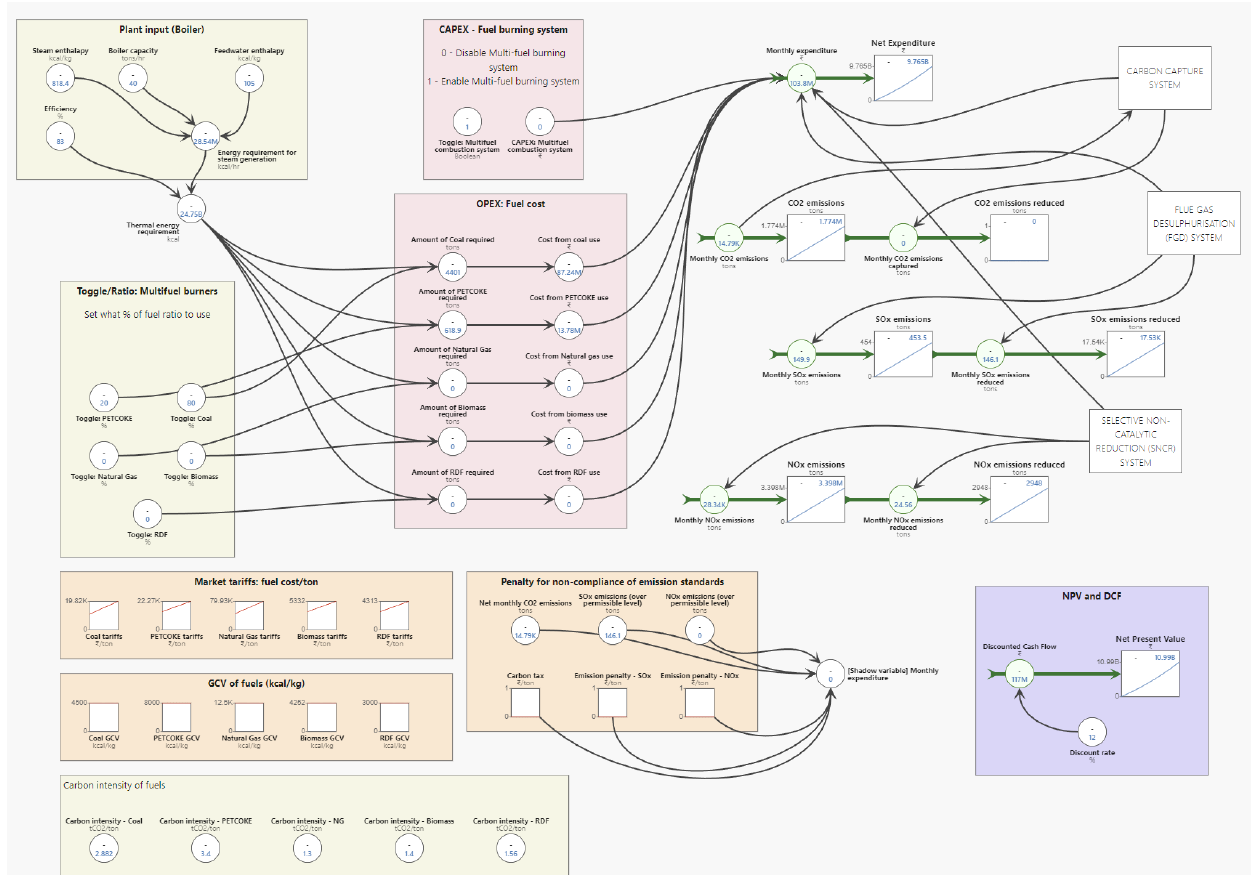
Figure 5. Stock-and-flow diagram of the proposed model.